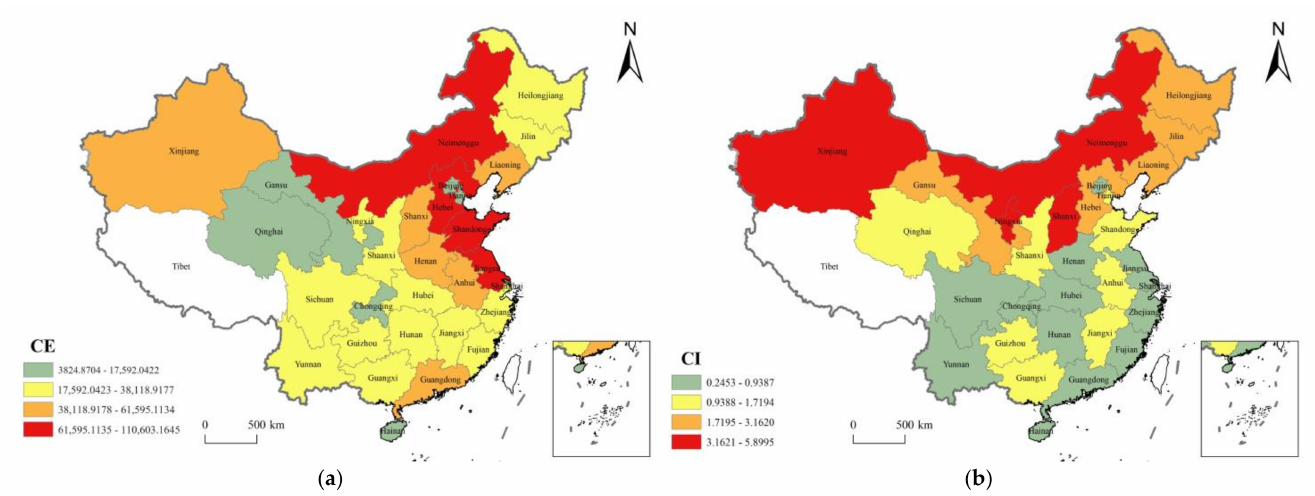
Figure 4. Spatial distribution of CE and CI in China in 2019. ( a ) Spatial distribution of CE. ( b ) Spatial distribution of CI. (Note: The graphics are drawn by ArcGIS software (Version 10.8) based on the results of CE and CI